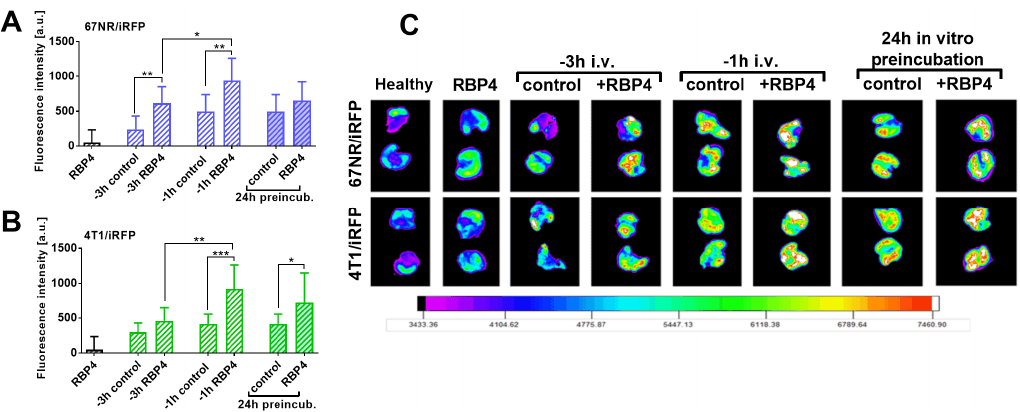
Figure 4. Lung fluorescence images after injection of 67NR/iRFP and 4T1/iRFP cells preceded by RBP4